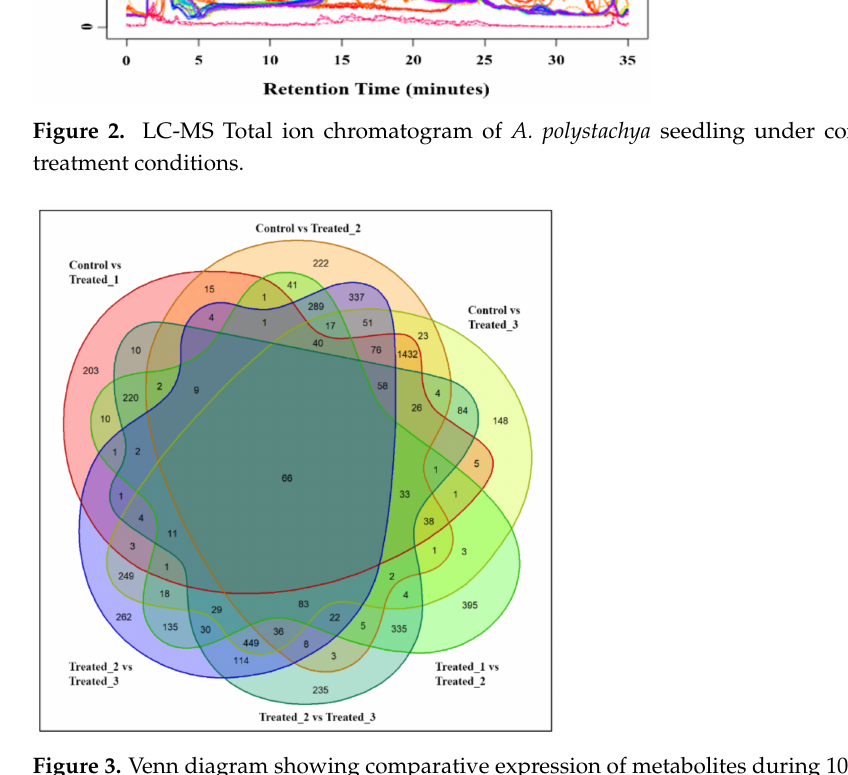
Figure 3. Venn diagram showing comparative expression of metabolites during 10 mM SA stressed condition in A. polystachya